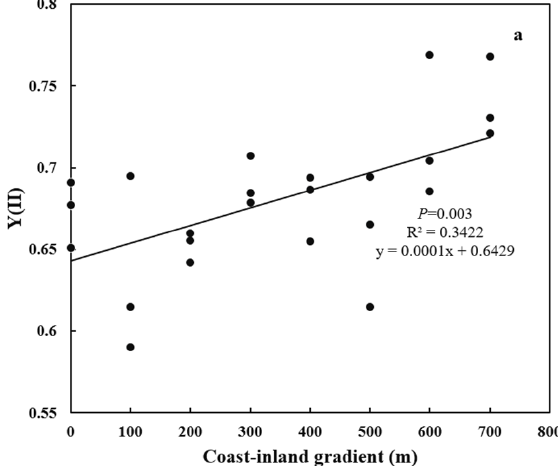
Figure 2. Variations in Y(II) for P. thunbergii along the coast-inland gradient.